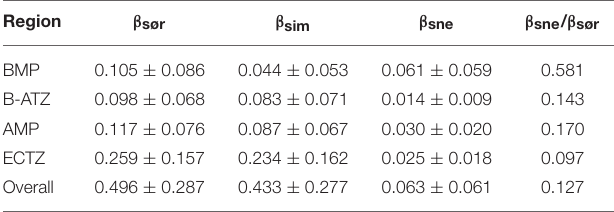
The partitioning represents the contribution of turnover and nestedness-resultant processes. Mean ± SD values are presented for the whole South African coast, as well as for each of the four bioregions.